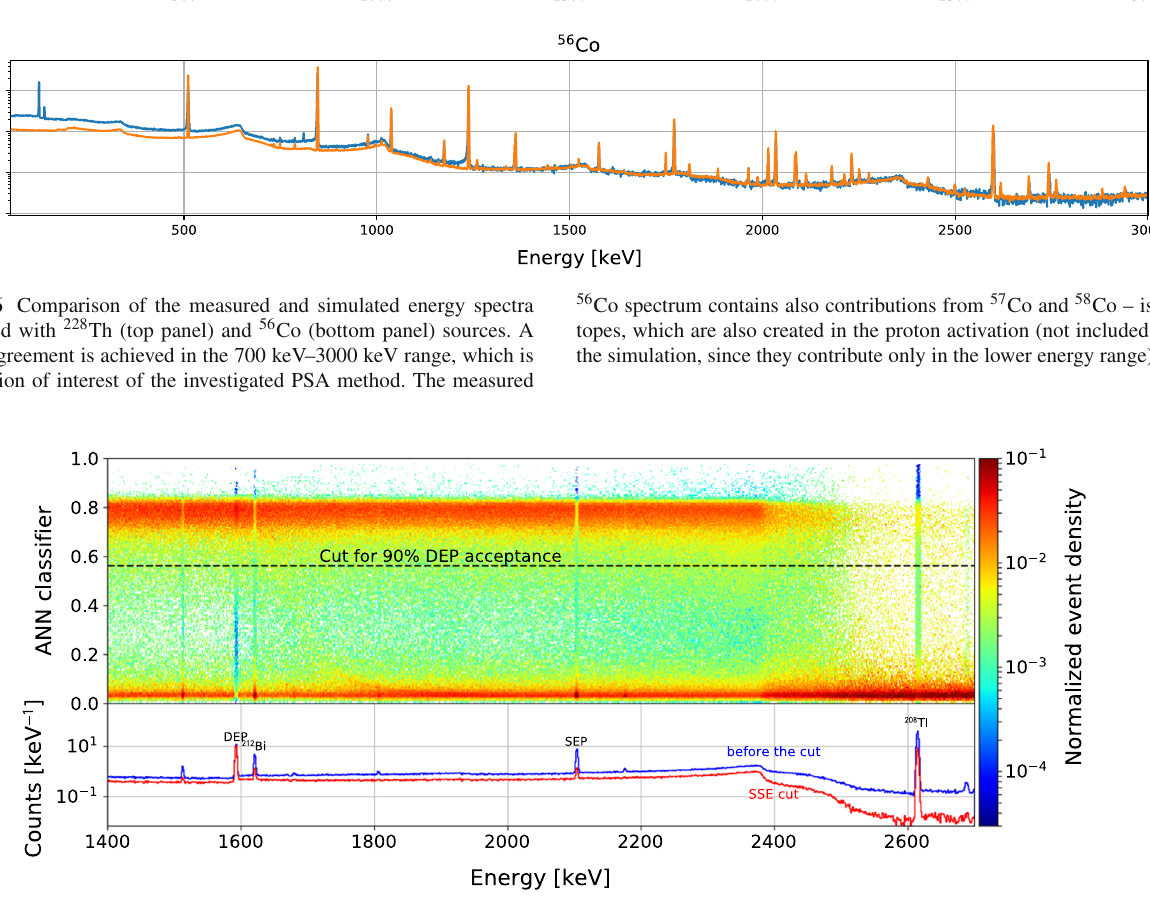
Fig. 17 2D histogram showing distribution of the classified 228 Th events (simulated for the temperature equal to 50 K). The bottom panel shows the corresponding energy spectrum. For comparison with the measured data see Fig. 6 Table 3 Comparison of the acceptances for events from the 228 Th dataset (third column) and for the simulated pulses (various temperatures). The best agreement is obtained for 50 K. The temperature in the simulation is treated as a parameter influencing the charge drift velocities Energy (keV) Peak